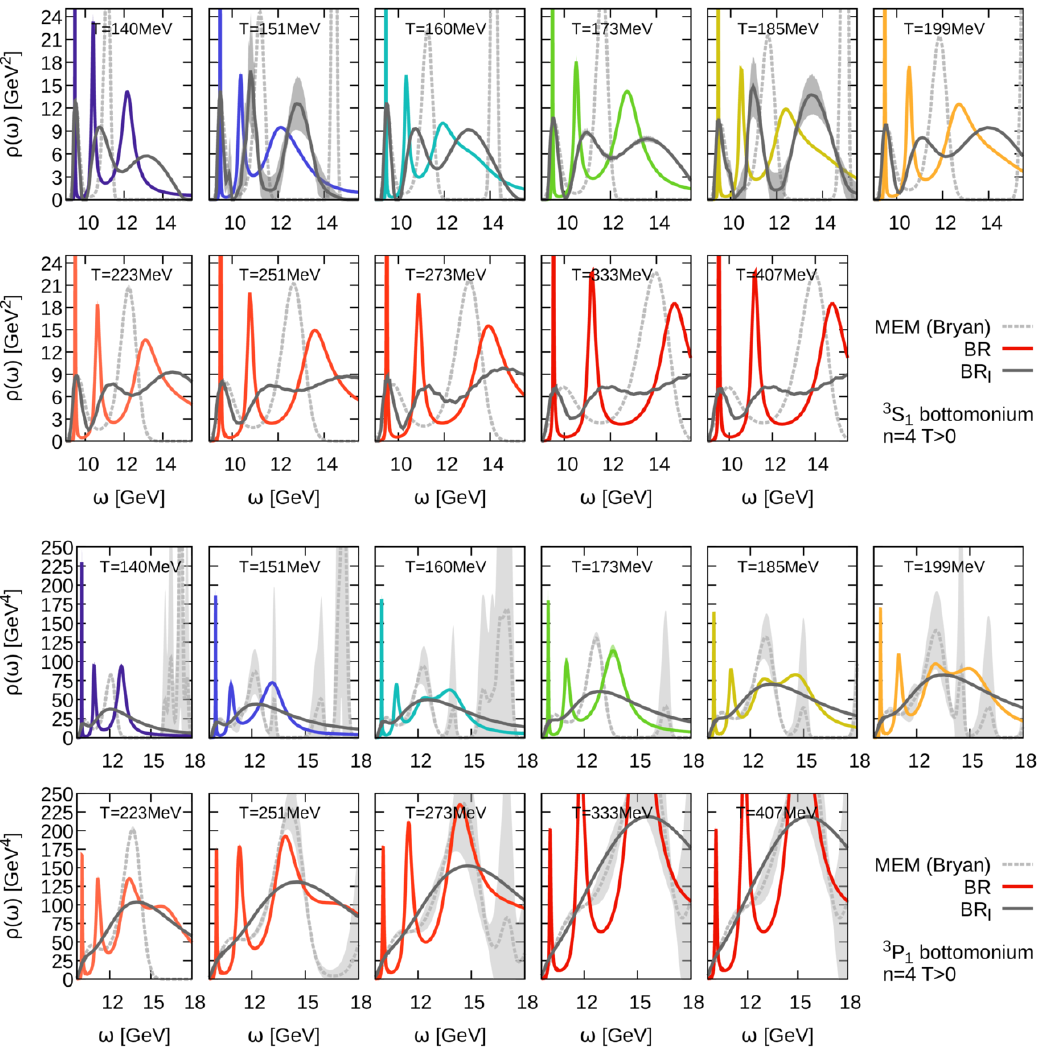
Figure 21 . Finite temperature spectral functions for bottomonium obtained from the standard BR method (colored solid) the MEM (gray dashed) and the smooth BR method (dark gray solid) The top two rows contain the results for the 3 S 1 channel, each panel showcasing a di(cid:11)erent temperature. The lower two rows on the other hand contain the 3 P 1